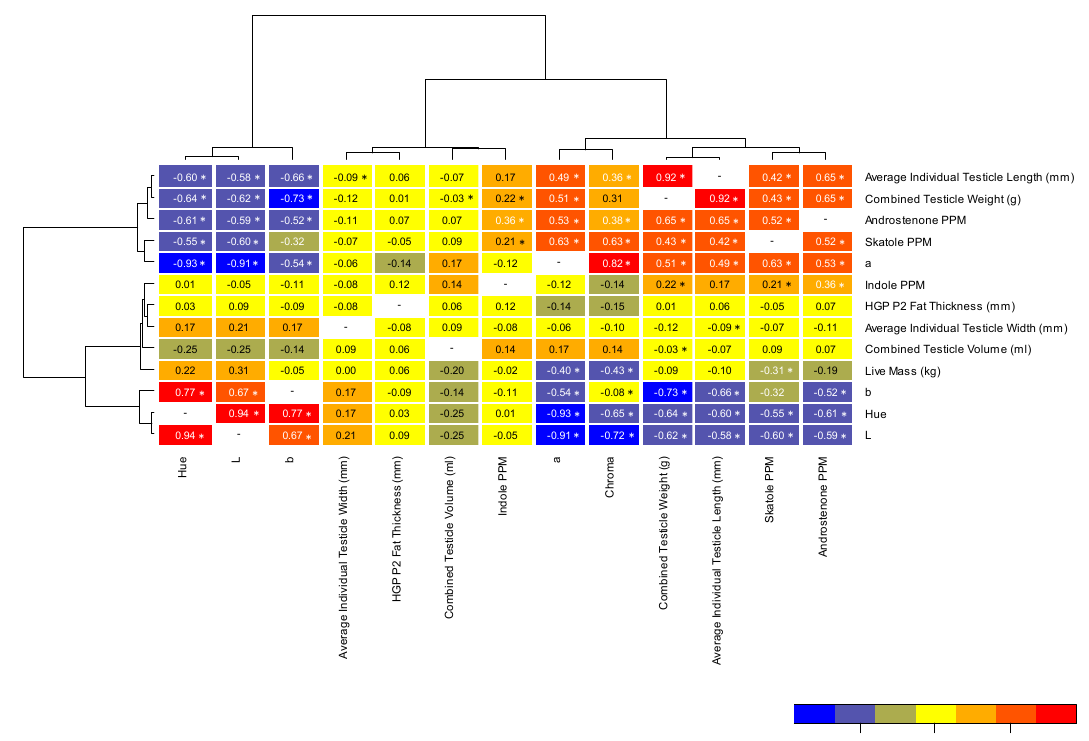
Figure 2. Pearson’s correlation coefficient heatmap for body mass, Hennessy Grading Probe backfat thickness (HPG at P2 location), testicle size and color ( L* , a* , b* , hue and chroma) parameters and backfat concentrations of androstenone, skatole and indole. Linkage distance within the clustering analysis indicates how closely the correlations of these variables match one another. The legend indicates the strength and direction of the correlations between the parameters, and Spearman’s correlation coefficients are shown between parameters. Significant differences are indicated by asterisks, at p < 0.05.